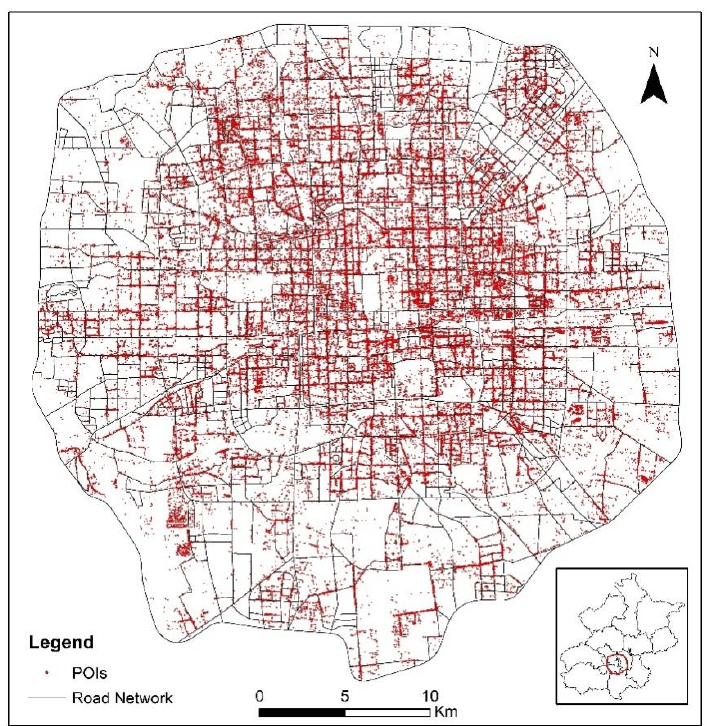
Figure 1. Study area within the Fifth Ring Road of Beijing, China.